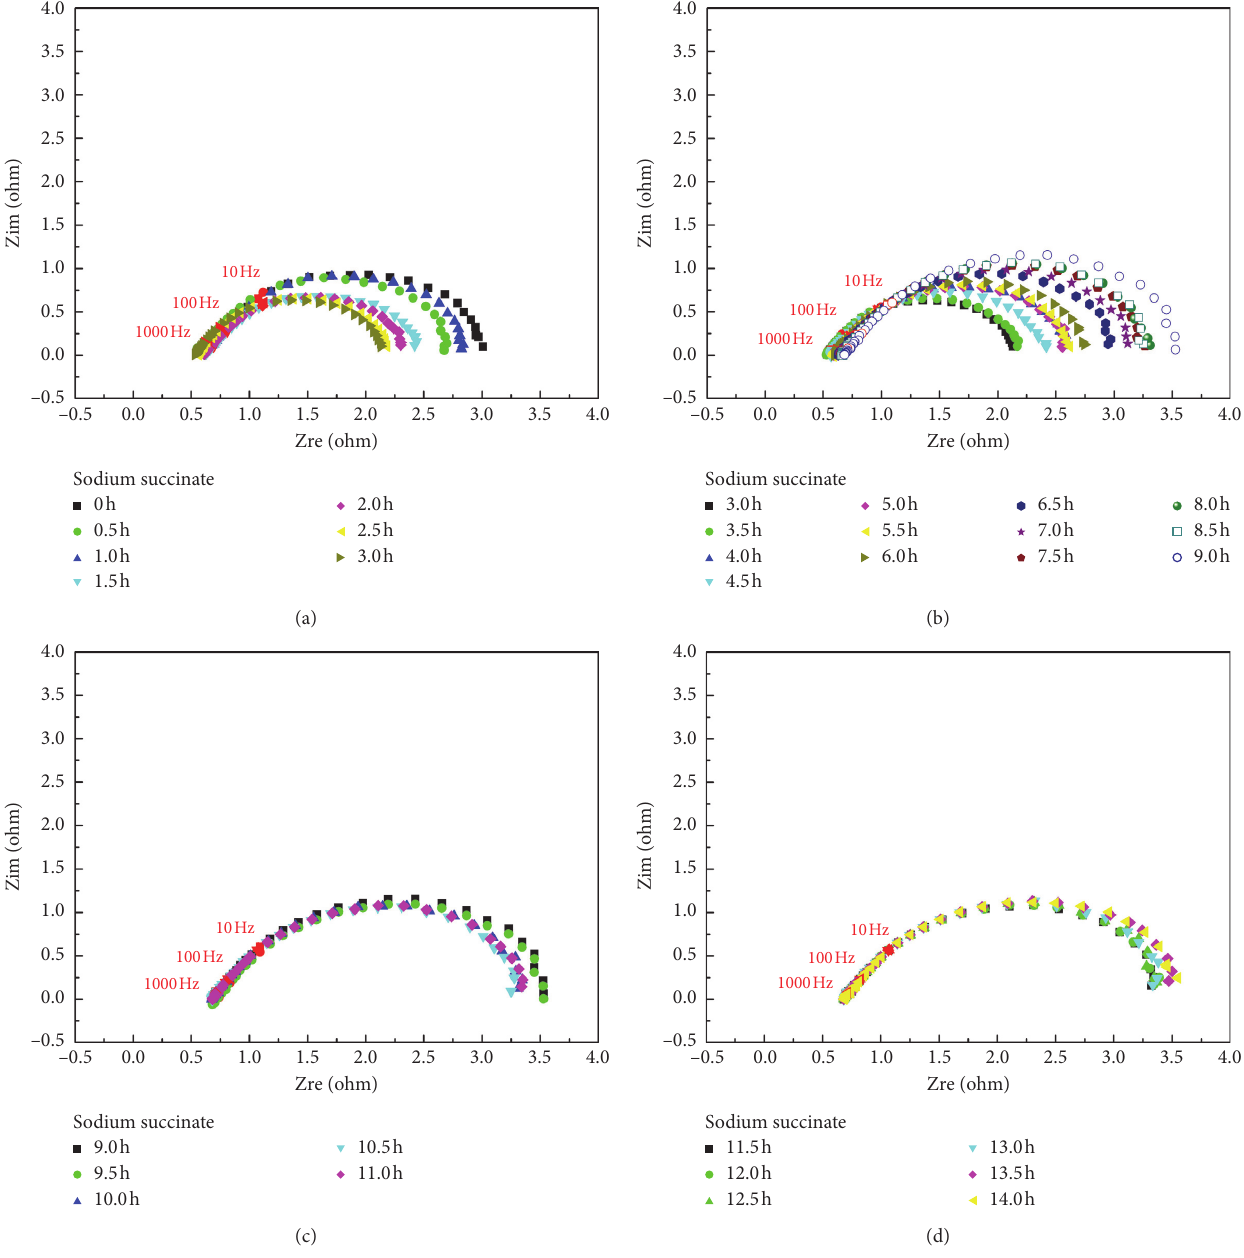
Figure 6: Nyquist diagrams at different times under the condition of adding sodium succinate. (a) 0–3.0h. (b) 3.0h–9.0h. (c) 9.0h–11.0 h. (d) 11.5h–14.0